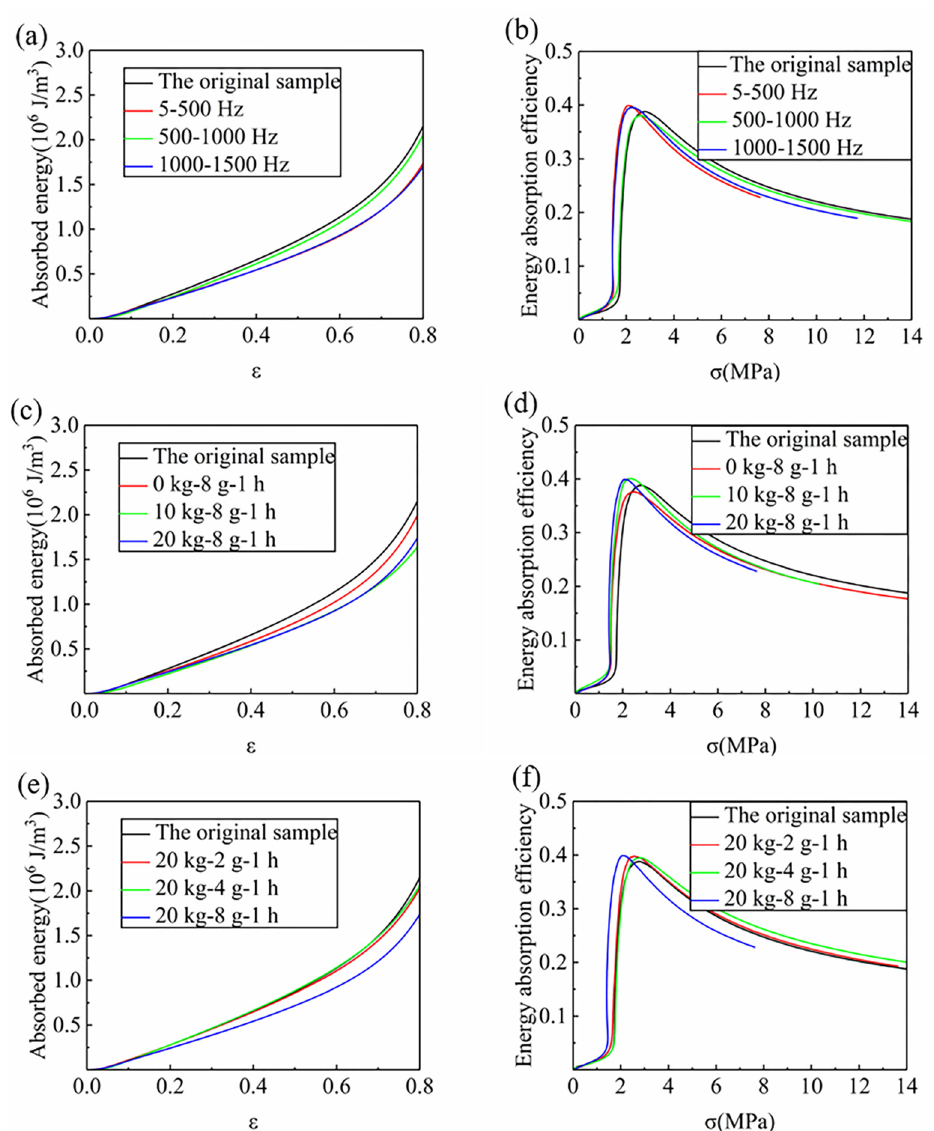
Figure 7. Absorbed energy-strain curve ( a , c , e ) and energy absorption efficiency-stress curve ( b , d , f ) of the RPUF under different vibration conditions, ( a , b ) Different frequency ranges, ( c , d ) Different mass blocks, ( e , f ) Different accelerations.